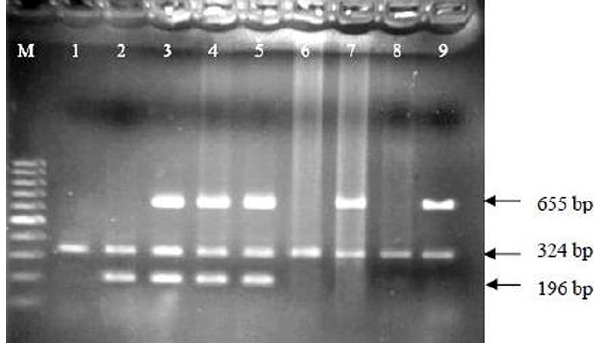
Figure 3. Agarose gel electrophoresis of PCR products obtained from C. perfringens isolated from Kermani sheep dong sample. M: marker (DNA ladder, 100 bp); lanes 1, 6 and 8: C. perfringens type A isolates; lane 2: C. perfringens type C isolates; lanes 3 to 5: C. perfringens type B isolates; lanes 7 and 9: C. perfringens type D